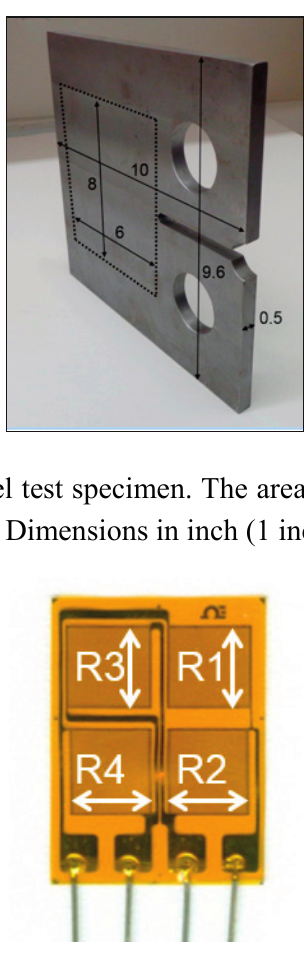
Figure 5. Unit full-bridge sensor (arrows indicate orientation of